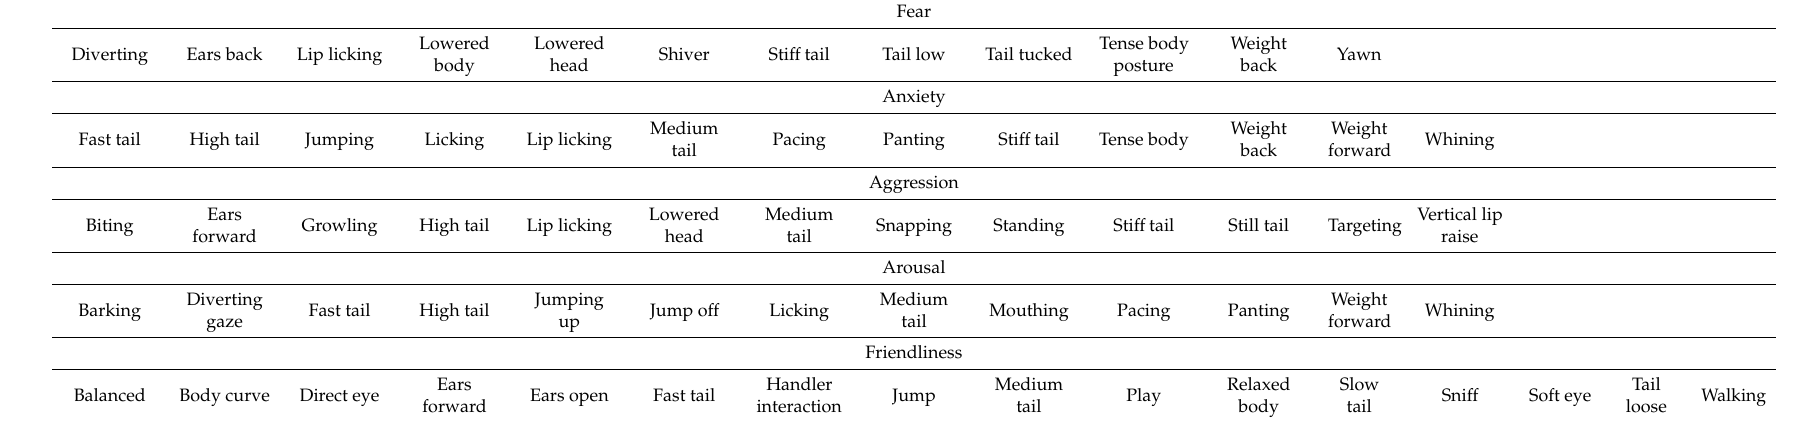
Table 2. The behaviours contributing to the behavioural states fear, anxiety, aggression, arousal, and friendliness.